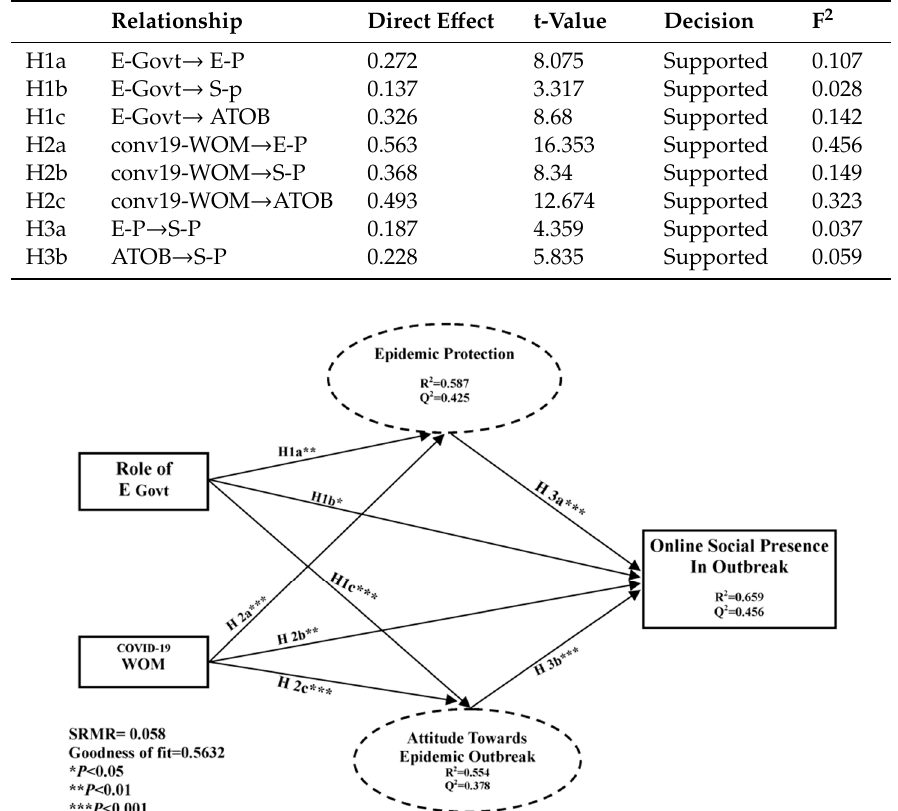
Figure 4. Structured model and direct effects.